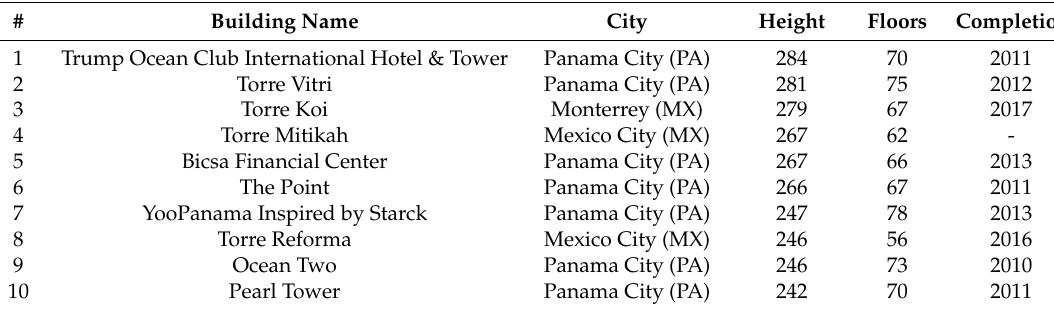
Table 11. Central America’s 10 tallest skyscrapers in